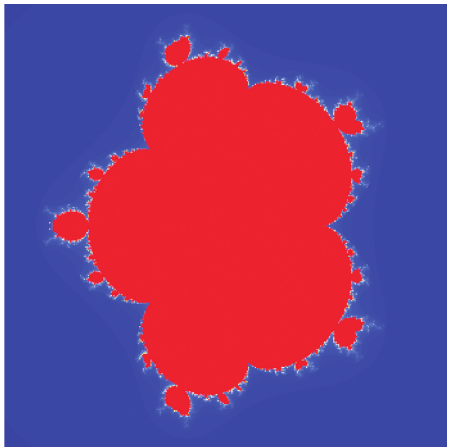
Figure 22: Cubic Mandelbrot set in JSOmhh.